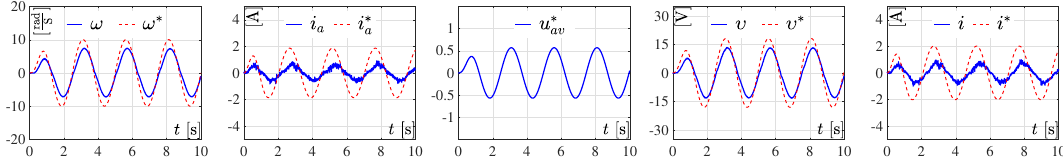
Figure 13. Experimental results for a sinusoidal trajectory with exponential amplitude. The results of the measured variables correspond to ω , i a , υ , i , and the results of the reference variables are ω ∗ , i ∗ a , u ∗ av , υ ∗ , i ∗ .